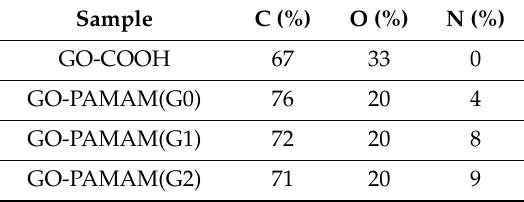
Figure 4. The XPS Survey spectra of GO-COOH before ( a ) and after functionalization ( b ) with Table 1. Atomic composition of GO-COOH before and after PAMAM functionalization .